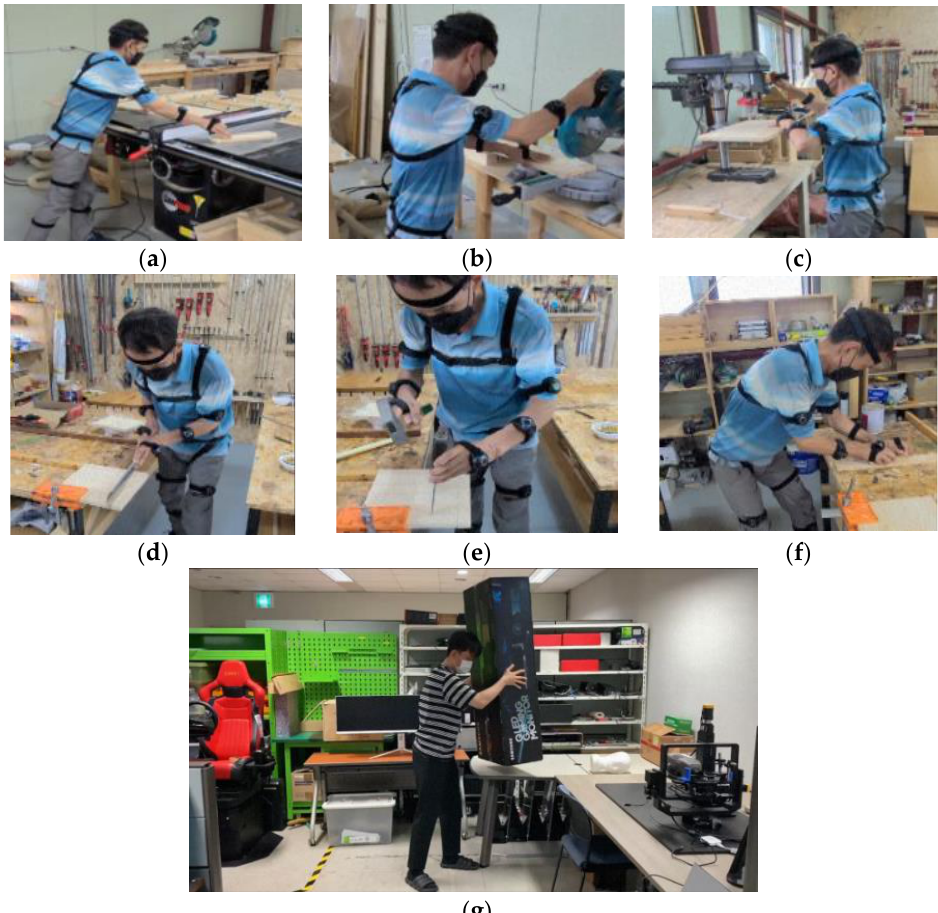
Figure 18. Working posture depending on wood processing tools: ( a ) cutting machines; ( b ) circular saws; ( c ) drilling machines; ( d ) saws; ( e ) chisels; ( f ) planers; ( g ) loading/unloading of heavy objects.